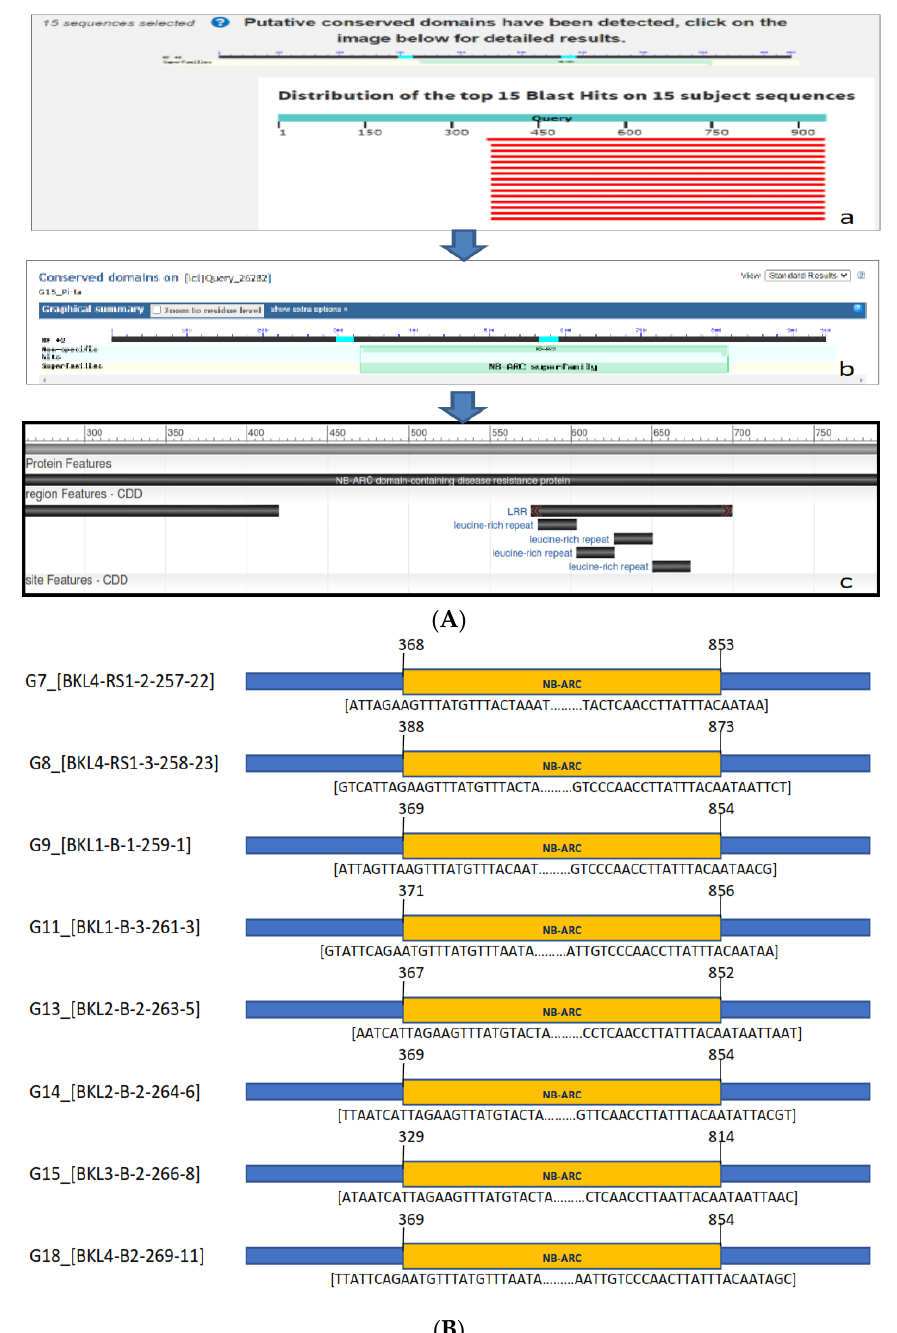
Figure 6. ( A ) BlastX translated nucleotide protein in the NCBI gene bank; ( a ) query sequence with 15 subjects homologous to the data in the gene bank; ( b ) the putative conserved domain detected by the query gene containing the NB-ARC superfamily; ( c ) the NBS-LRR protein has been identified as a key defense resistance mechanism in plants. ( B ) The conserved domain in eight blast-resistant rice lines detected the location of NB-ARC using BlastX. The yellow region showed the location of NB-ARC at sequence lengths between 300–870 (±450 bp).